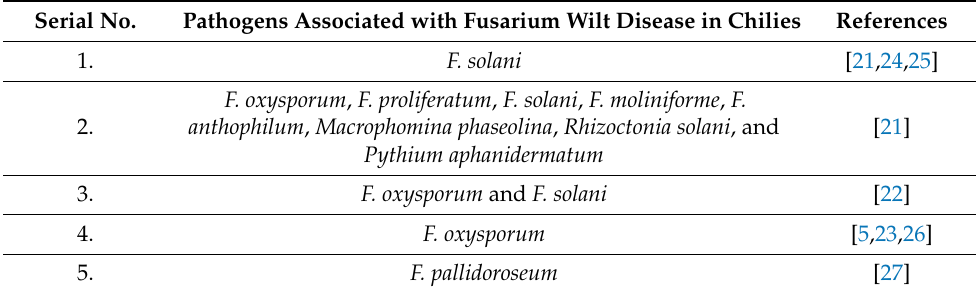
Table 1. Reported pathogens associated with wilt disease in chilies. Serial